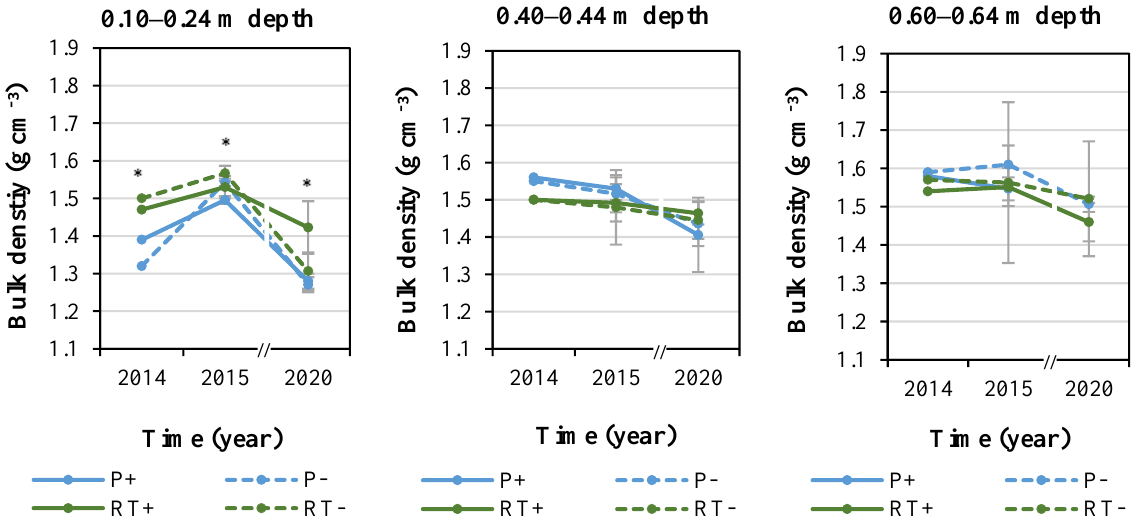
Figure 1. Median of the bulk density in 2014, 2015, and 2020 in depths of 0.10–0.24 m, 0.40–0.44 m, and 0.60–0.64 m. P: plow, RT: reduced tillage, +/ − : with and without compost, ± standard deviation. Note: in 2020, the P+ value corresponding to a depth of 0.60 m is missing; in 2014 the standard deviation is not available. * Significant effects between treatments with p < 0.05 (Tukey’s HSD, see Text for details).